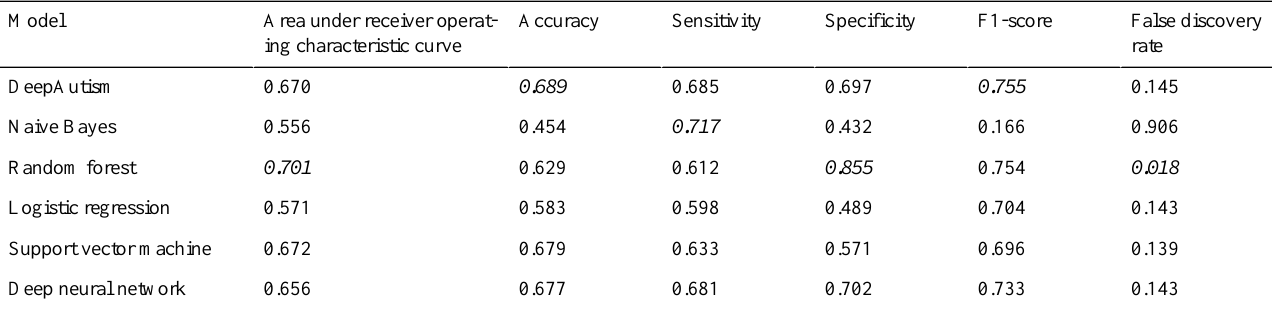
Table 2. Performance of the classifiers with respect to area under receiver operating characteristic curve, accuracy, sensitivity, specificity, F1-score, and false discovery rate on test sets with randomly picked 100 common variants.